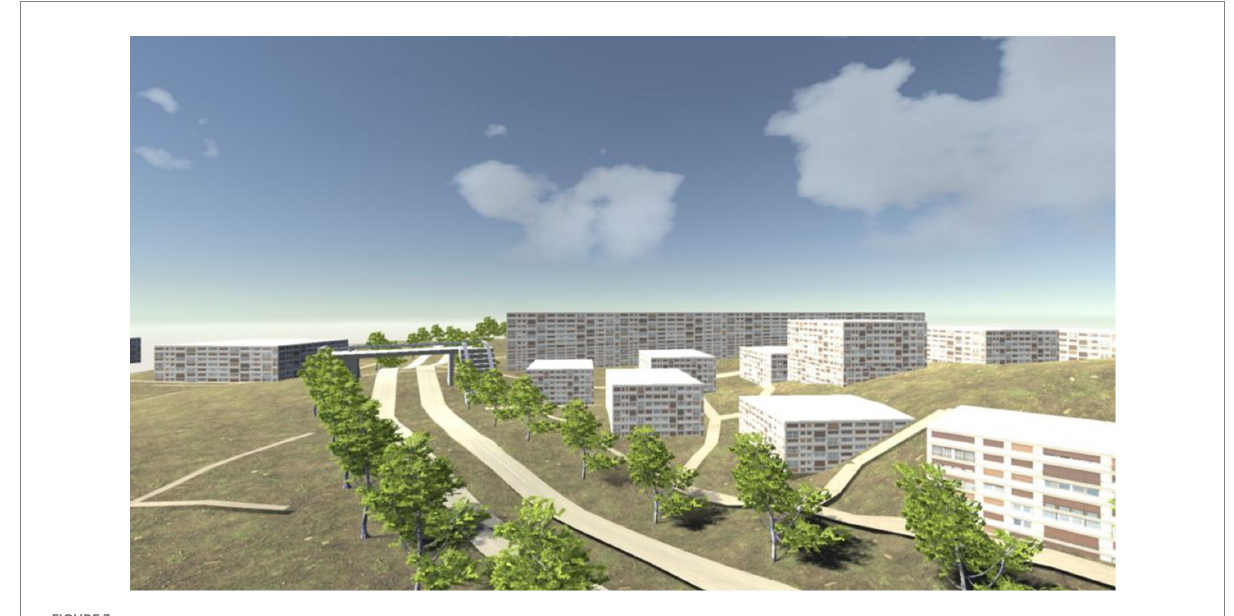
FIGURE 3 Game software “Digital Game-Virtual